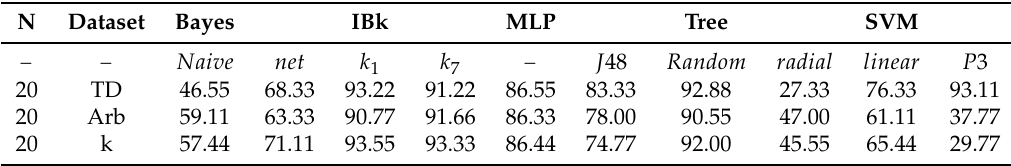
Table 4. Classification results of the time domain (TD), Arb, and K datasets separately. P3, third order